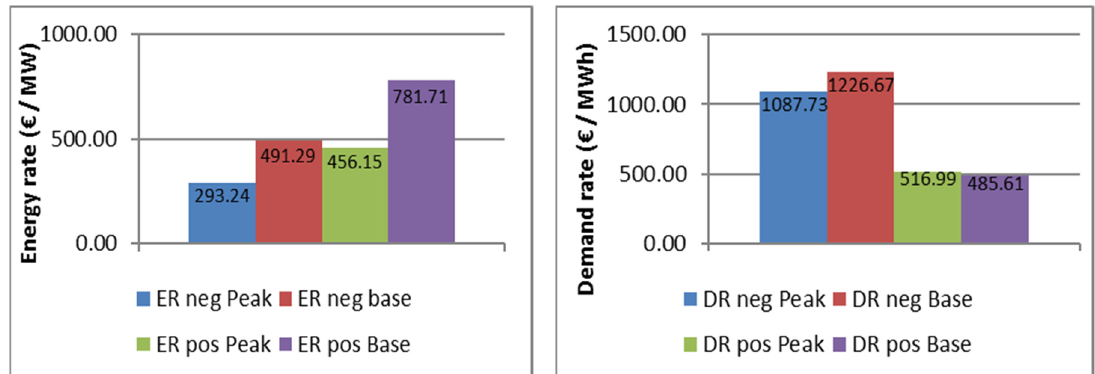
Figure 9. Energy rate (left plot) and demand rate (right plot) for secondary reserve capacity (base/peak; pos./neg.) in Germany, 2014. Source: own illustration, based on regelleistung.net